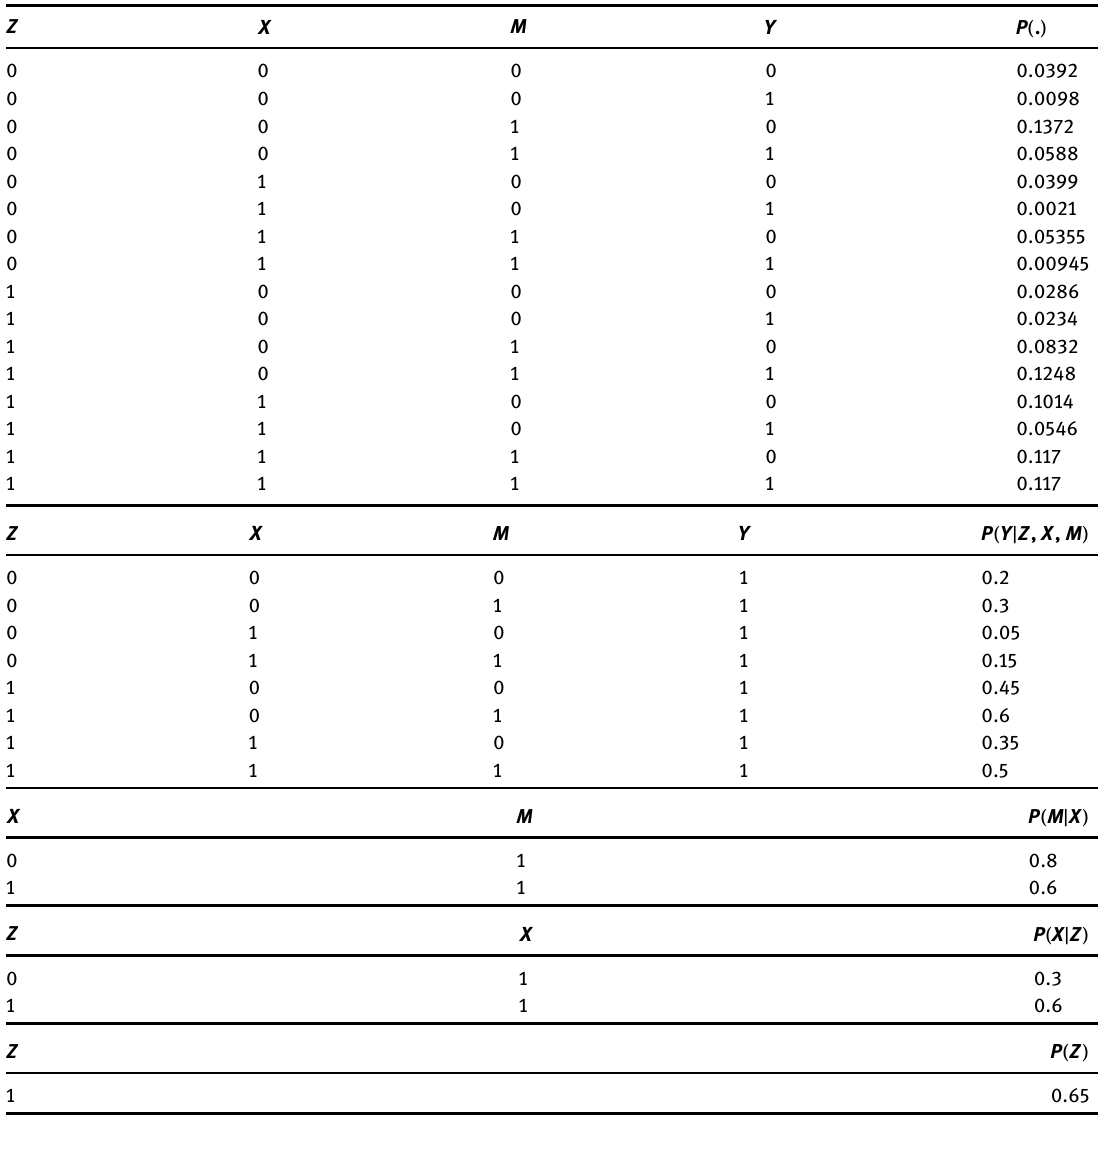
Table 1: Probability distribution of pharmocological data of Example 2.1. Conditional probability tables from the model in Figure 3 are given, but truncated only to necessary probabilities